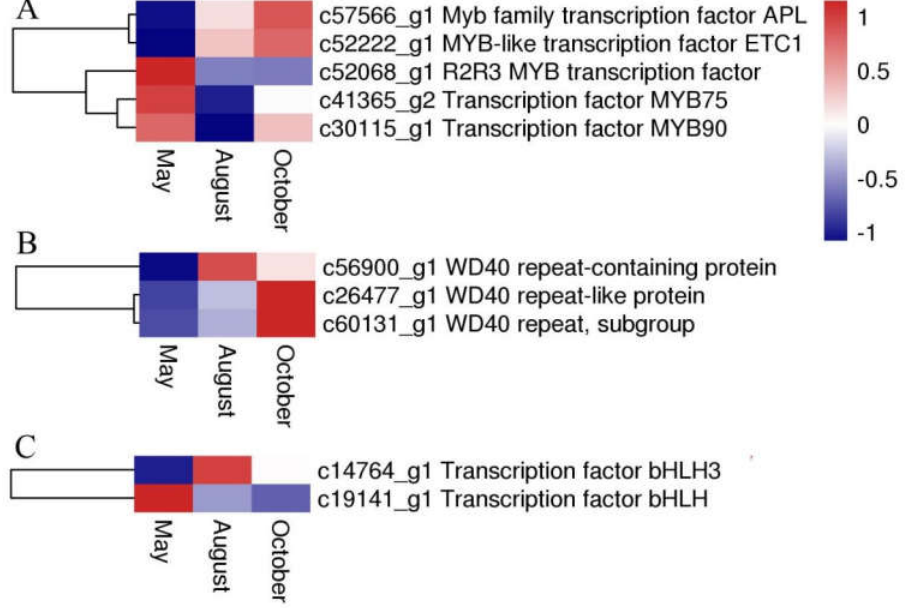
Figure 10. The expression level of DEGs encoding MYB ( A ), WD40 ( B ), and bHLH ( C ). Blue and red colors represent different levels of gene expression, and the color scales reflect a log 2 -transformed mean of FPKM values.